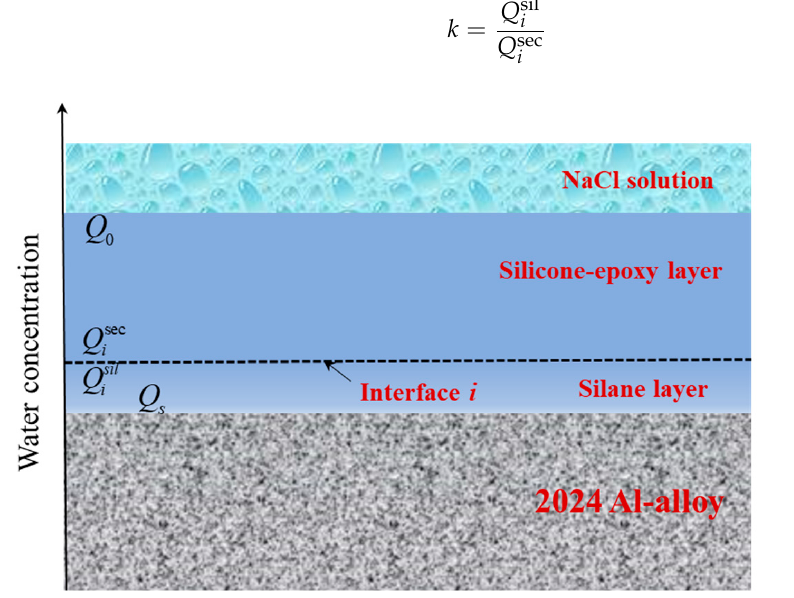
Figure 11. A schematic illustration of the water concentration jump on the silane layer/silicone- epoxy interface.